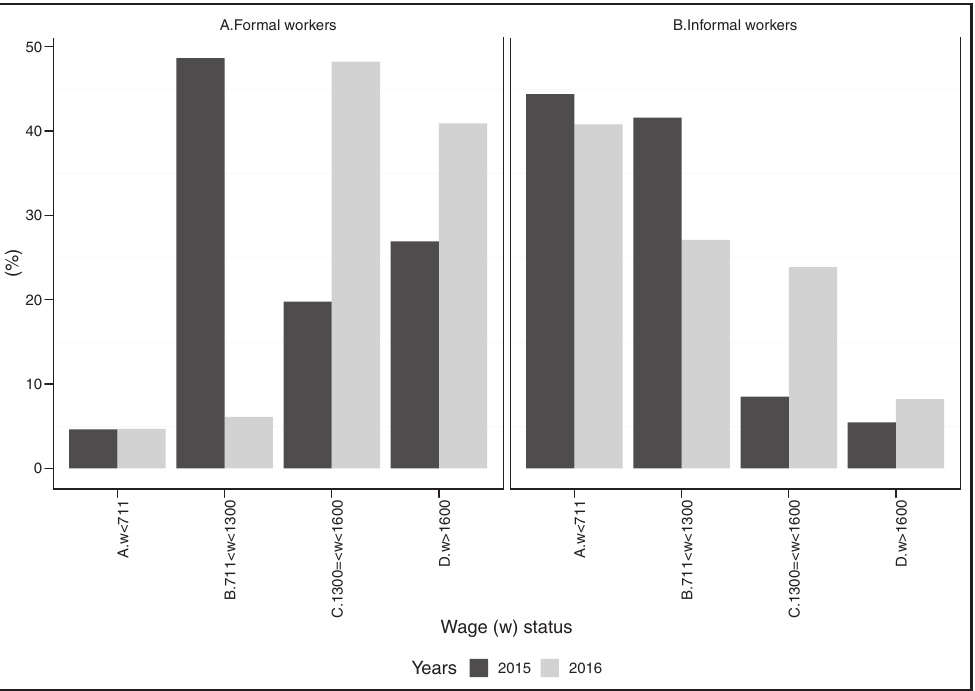
Figure A3 Wage groups potentially affected by the minimum wage increase in 2016, by informality